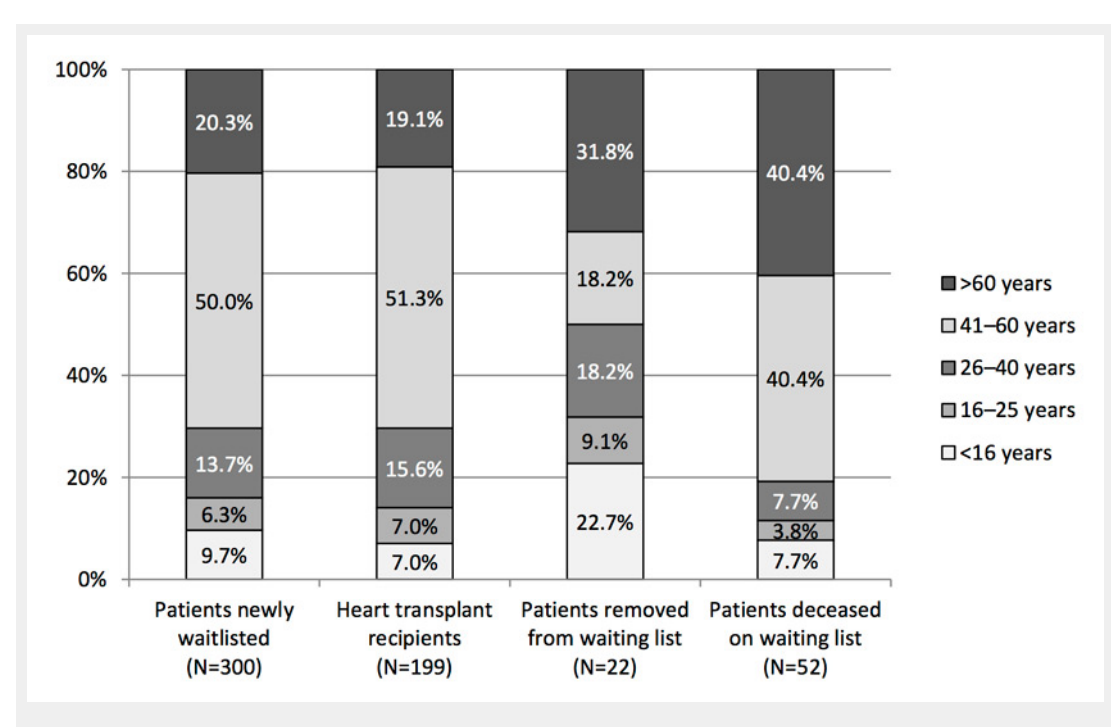
Figure 3 Age distribution of patients newly waitlisted, transplanted, removed from waiting list, and deceased on waiting